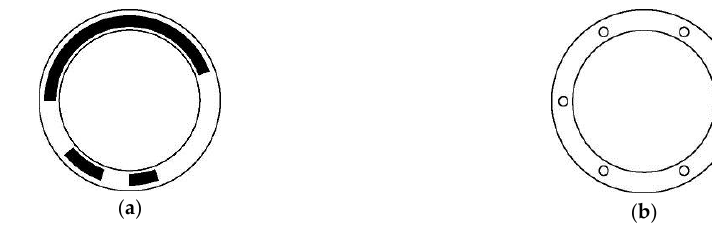
Figure 3. Disc pattern and reading head distribution of absolute encoder using a length-6 period-36 necklace ordering STGC. ( a ) Schematic of the coding disc, where white the area indicates “0”, and the black area indicates “1”; ( b ) Schematic of the reading disc, where the six small circles denote the six reading heads and are evenly distributed around the whole coding track.